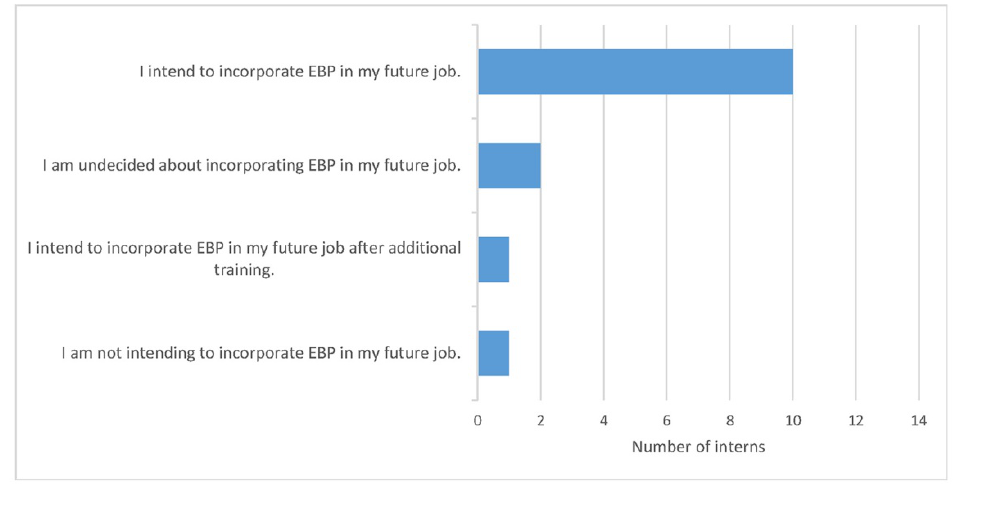
Figure 1 Dietetic interns’ intentions to use EBP in their future jobs